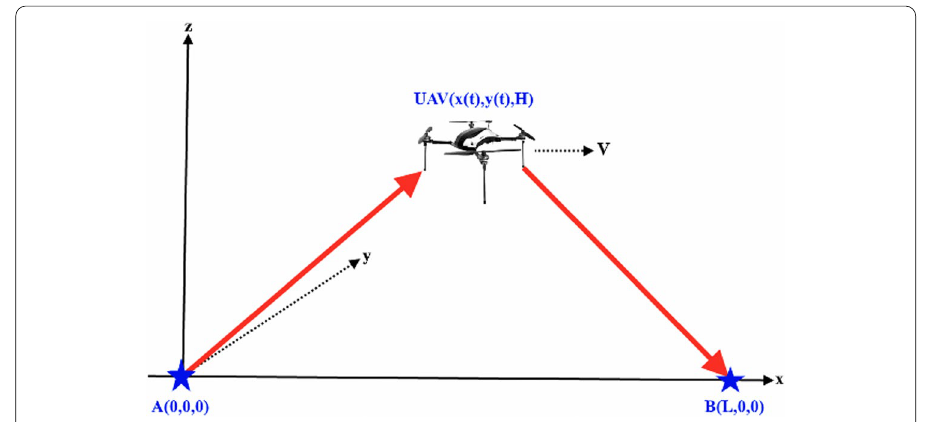
Fig. 1 Analytical model of the UAV-relayed wireless system